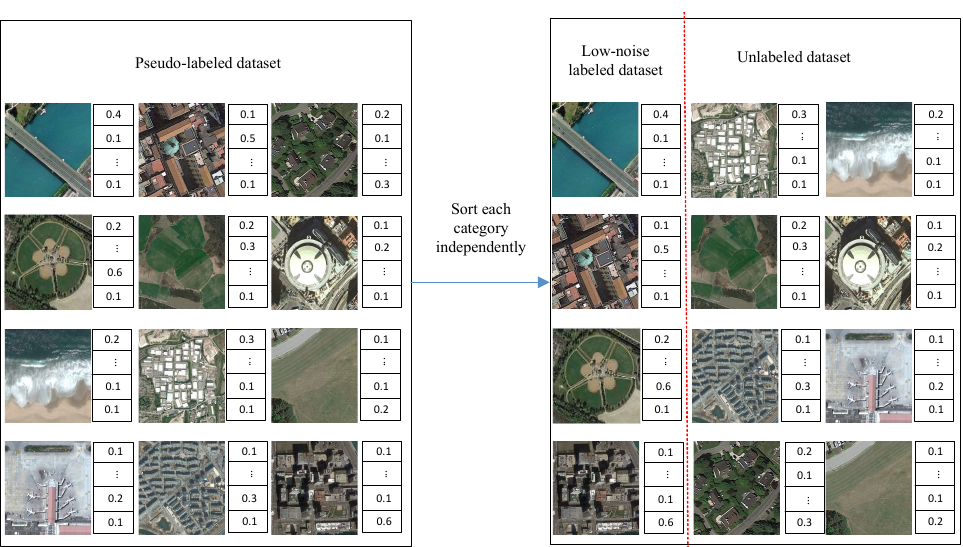
Figure 3. Framework of high-probability sample